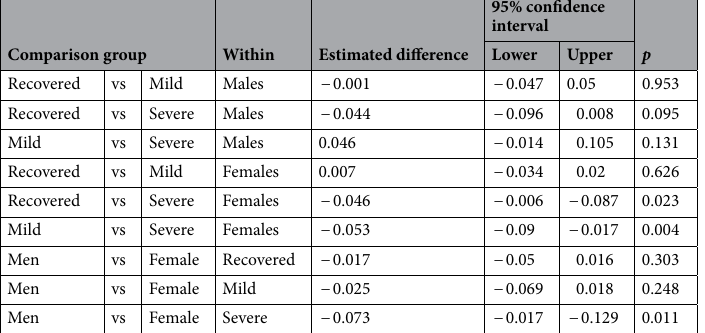
Comparison group Within